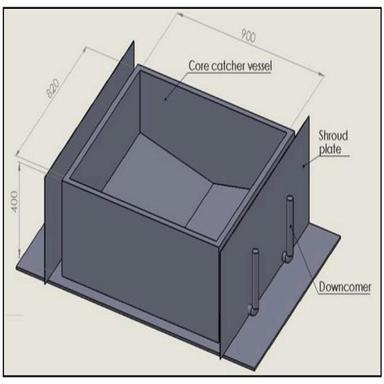
The schematic of the scaled down core catcher vessel placed inside the tank along with the shroud plate and downcomer assembly.